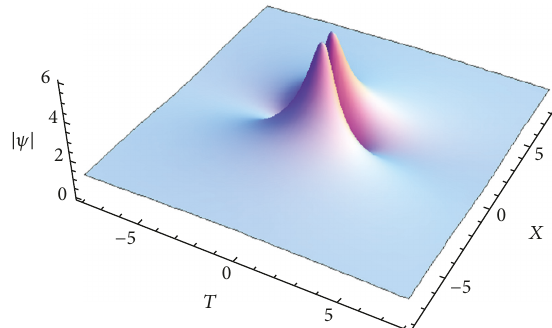
Figure 21: Rouge wave structure determined by the module of solution (84).